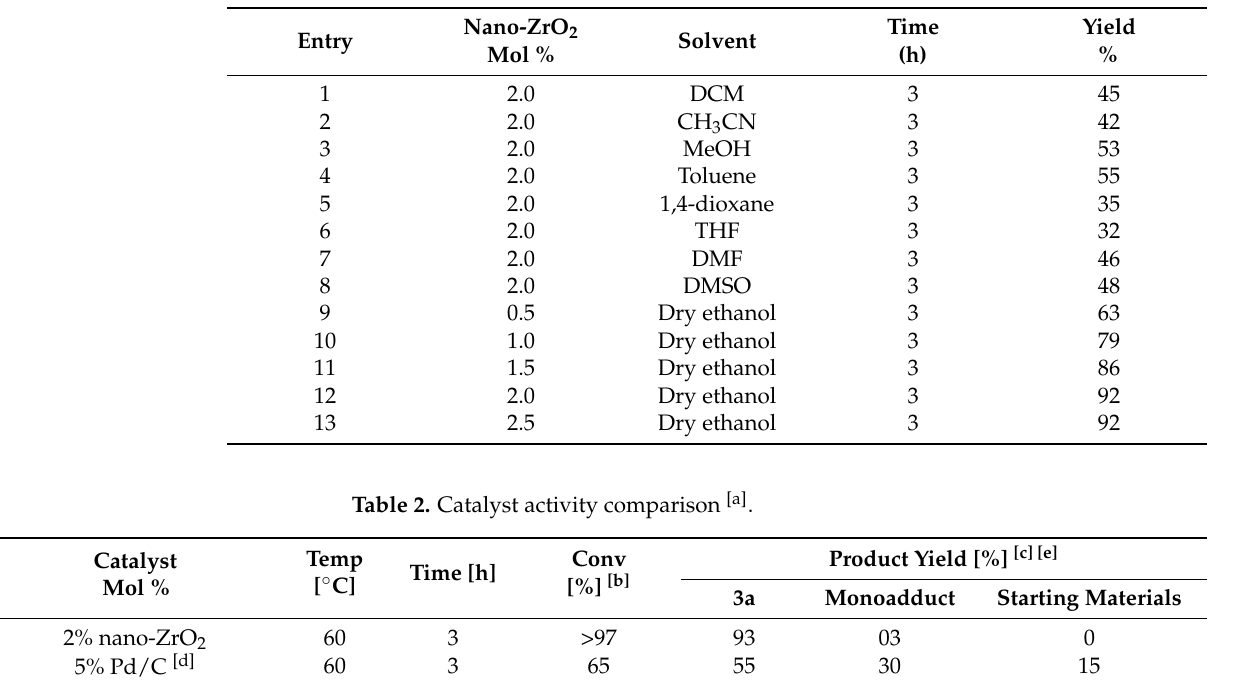
Table 1. Optimization study by solvent.